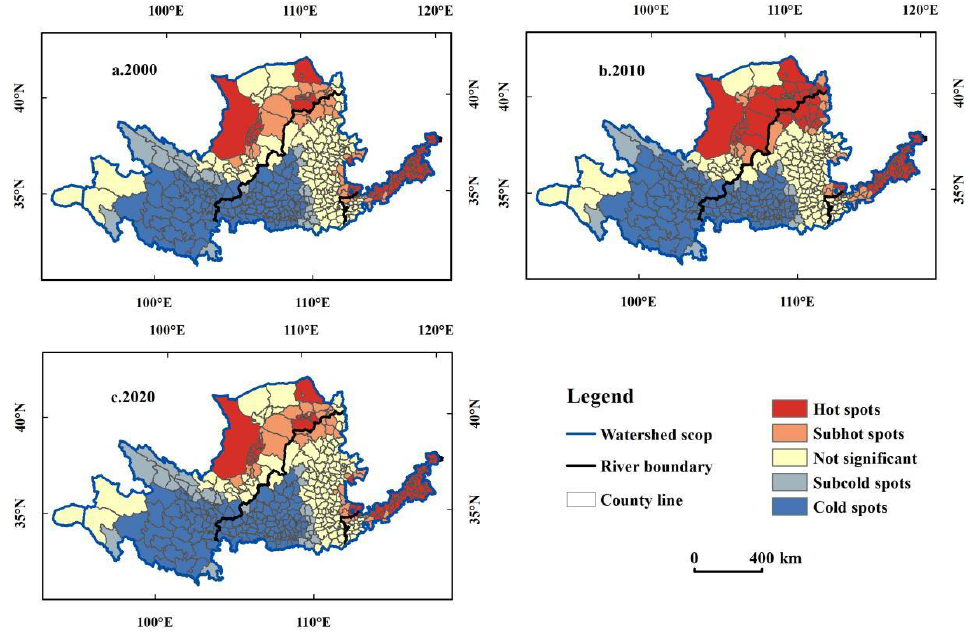
Figure 6. Distribution of carbon emissions hot and cold spots in the YRB: (a) 2000, (b) 2010, and (c) 2020. In 2000, hot spots were concentrated in Inner Mongolia and Ningxia of the upper reaches and Shandong Henan of the lower reaches. The hot spots in the upper reaches involved 18 counties (cities and districts) and in the lower reaches involved 48 counties (cities and districts) such as Fengqiu, Yanjin, Dongping, and Zouping (Figure 6).